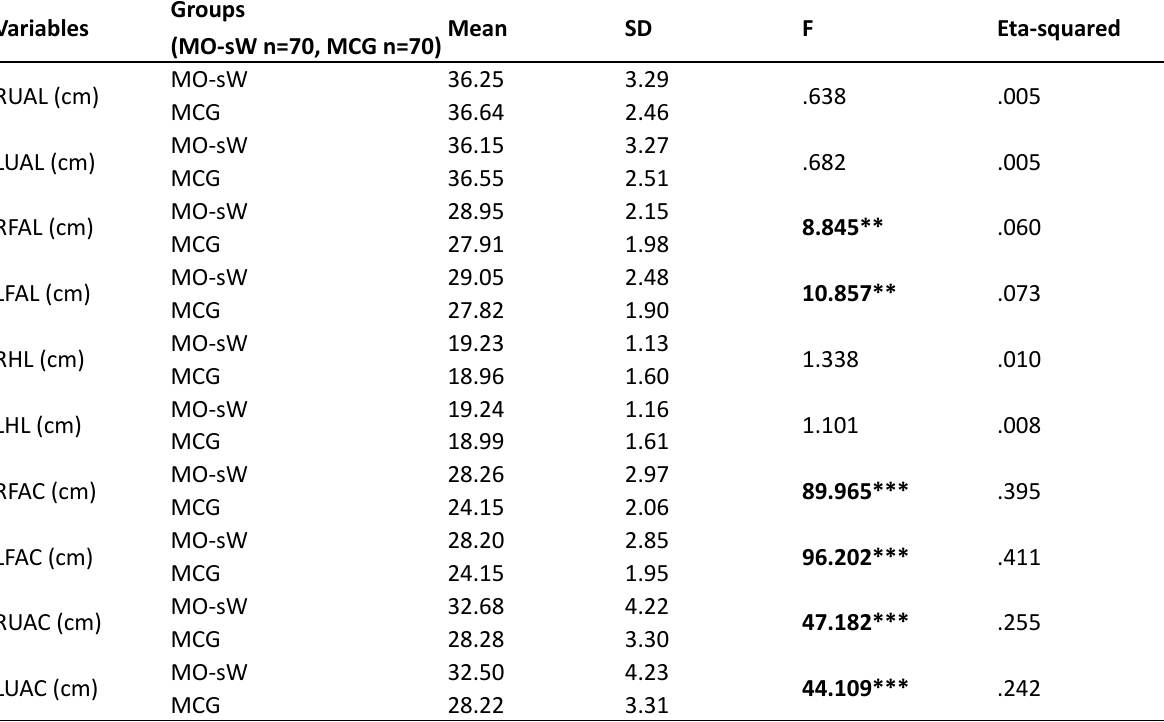
Table 2. The comparison of some anthropometric values of upper extremity of athletes and sedentary individuals Variables